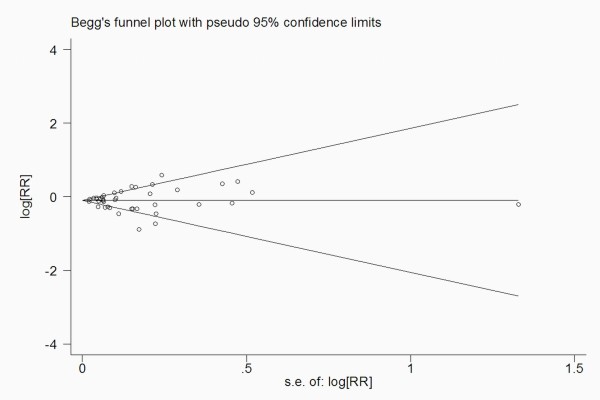
Publication bias in the studies. Begg's funnel plot indicating no publication bias in the studies included in this meta-analysis. No indication of publication bias was noted from both visualization of funnel plot and Egger's test.